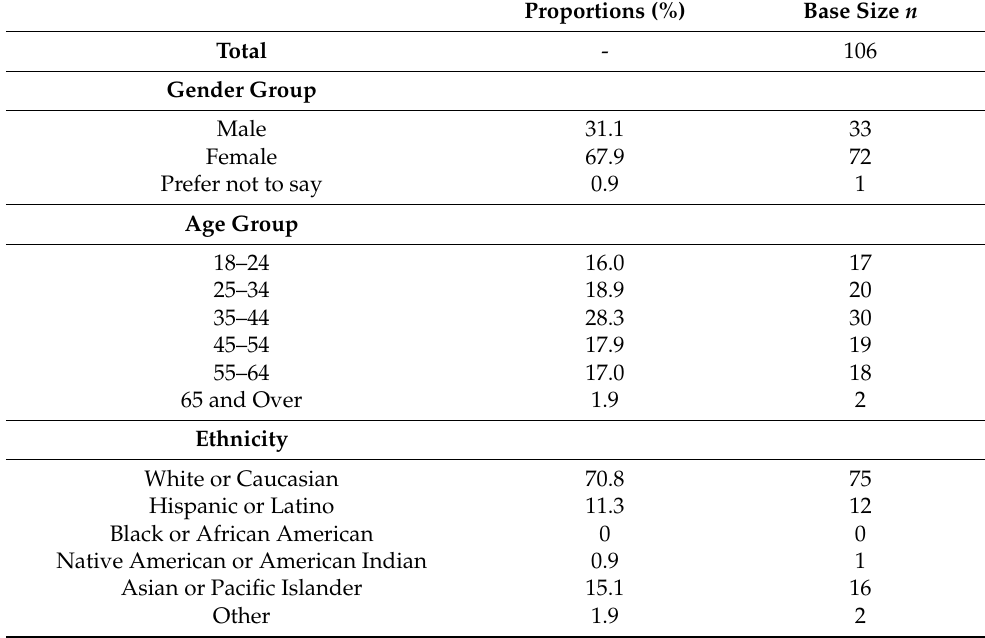
Table 1. Sociodemographics, insect familiarity, and cluster assignments of the participants ( n = 106) who responded to the demographics questionnaire. Proportions are rounded to the nearest tenth